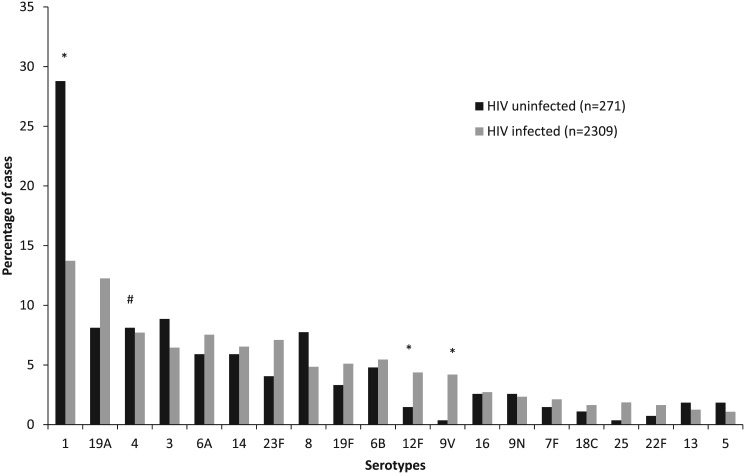
Distribution of pneumococcal serotypes amongst patients aged ≥15 years with invasive pneumococcal disease (IPD) in South Africa from 2003–2008, by HIV-infection status.# Reference group. *Statistically significant at p<0.05.